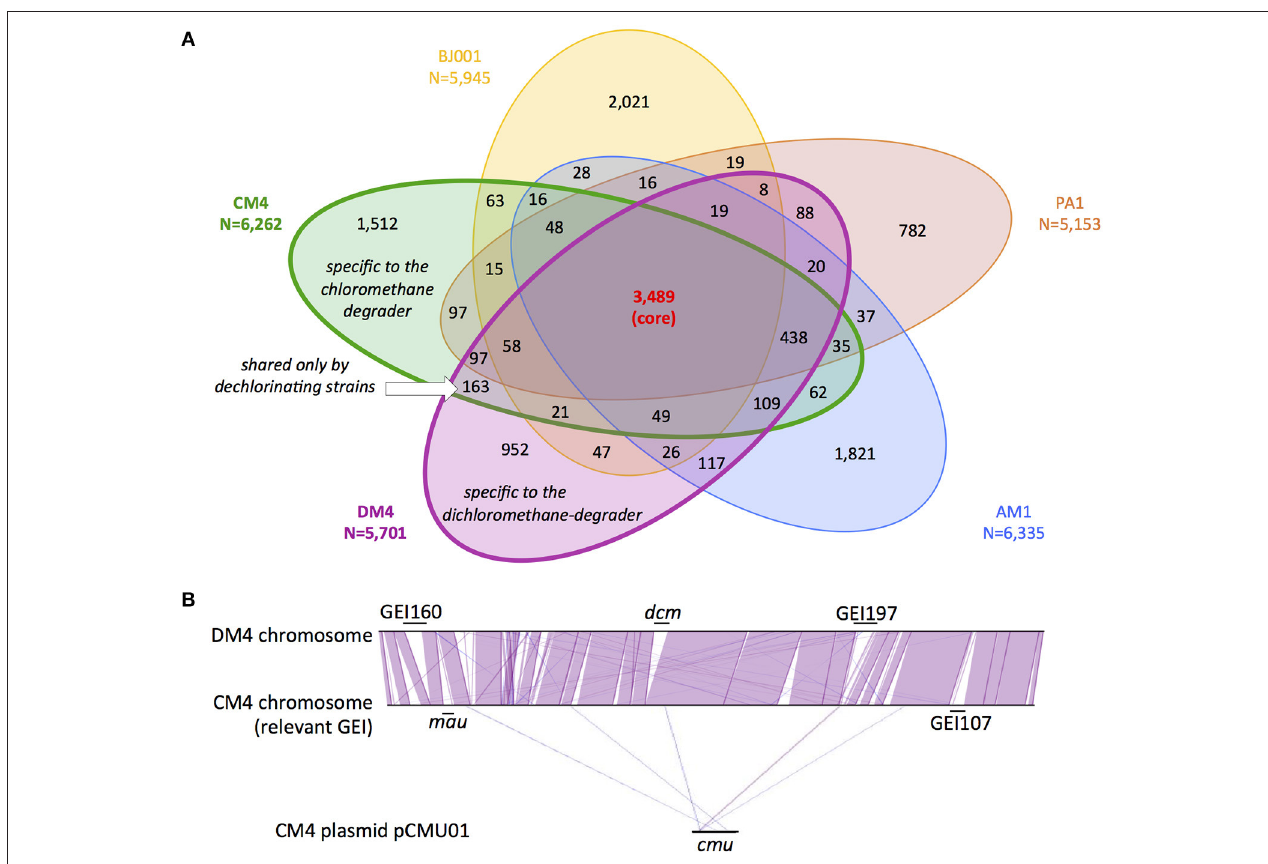
FIGURE 1 | Gene content and synteny in genomes of M. extorquens CM4 and DM4. Comparative genome analyses were performed on the sequenced and assembled genomes of M. extorquens dehalogenating strains CM4 and DM4, as well as strains AM1, PA1, and BJ001 (Vuilleumier et al., 2009; Marx et al., 2012), using MaGe (Vallenet et al., 2017) on the MicroScope online platform (see Materials and Methods). (A) Common homologous genes were defined and assigned to either core (found in all 5 strains), variable (found in 2–4 strains), shared (found only in CM4 and DM4) or specific (found in one strain only) genomes. (B) Synteny of CM4 and DM4 genomes indicating genomic islands (GEI) relevant to C 1 metabolism, i.e., dcm for dichloromethane utilization and mau for methylamine utilization (Vuilleumier et al., 2009), and cmu for CM utilization (380 kb plasmid pCMU01, Marx et al., 2012) (see Table 3 for GEI details). Synteny involved groups of at least 6 homologous genes (purple lines, strand conservation; blue lines, strand